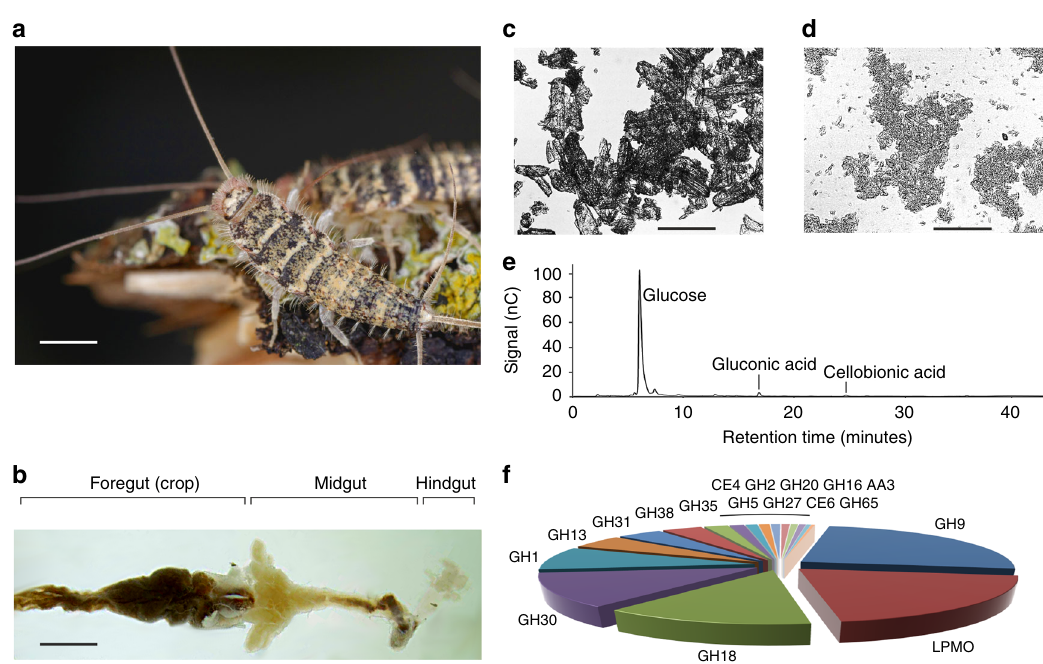
Fig. 1 Discovery of the AA15 LPMO family in T . domestica . ( a ) Photograph of live specimens of T . domestica in their natural environment. Scale bar, 300 µ m. ( b ) Dissected gut of T . domestica . The crop represents the largest portion of the foregut and the organ where food particles and digestive enzymes accumulate. Scale bar, 100 µ m. ( c ) Microscopic image of Avicel (microcrystalline cellulose). Average particle size is ~50 µ m. Scale bar, 30 µ m. ( d ) Microscopic image of food pellet collected from the crop of T . domestica fed on Avicel. Particle size is greatly reduced to ~5 µ m. Scale bar, 30 µ m. ( e ) HPAEC analysis of soluble extract isolated from the crop of T . domestica grown on Avicel. One dominant peak corresponding to glucose is clearly visible, plus minor peaks for gluconic acid and cellobionic acid. The identity of the peaks was determined by analyzing commercial standards. ( f ) Pie chart summary of the CAZymes identi fi ed in the crop of T . domestica grown on Avicel. Abundance values for the various families were calculated as molar percentage from emPAI values obtained from shotgun proteomics data (GH9 24.6%, LPMO 20.2%, GH18 13.2%, GH30 12.3%, GH1 8.4%, GH13